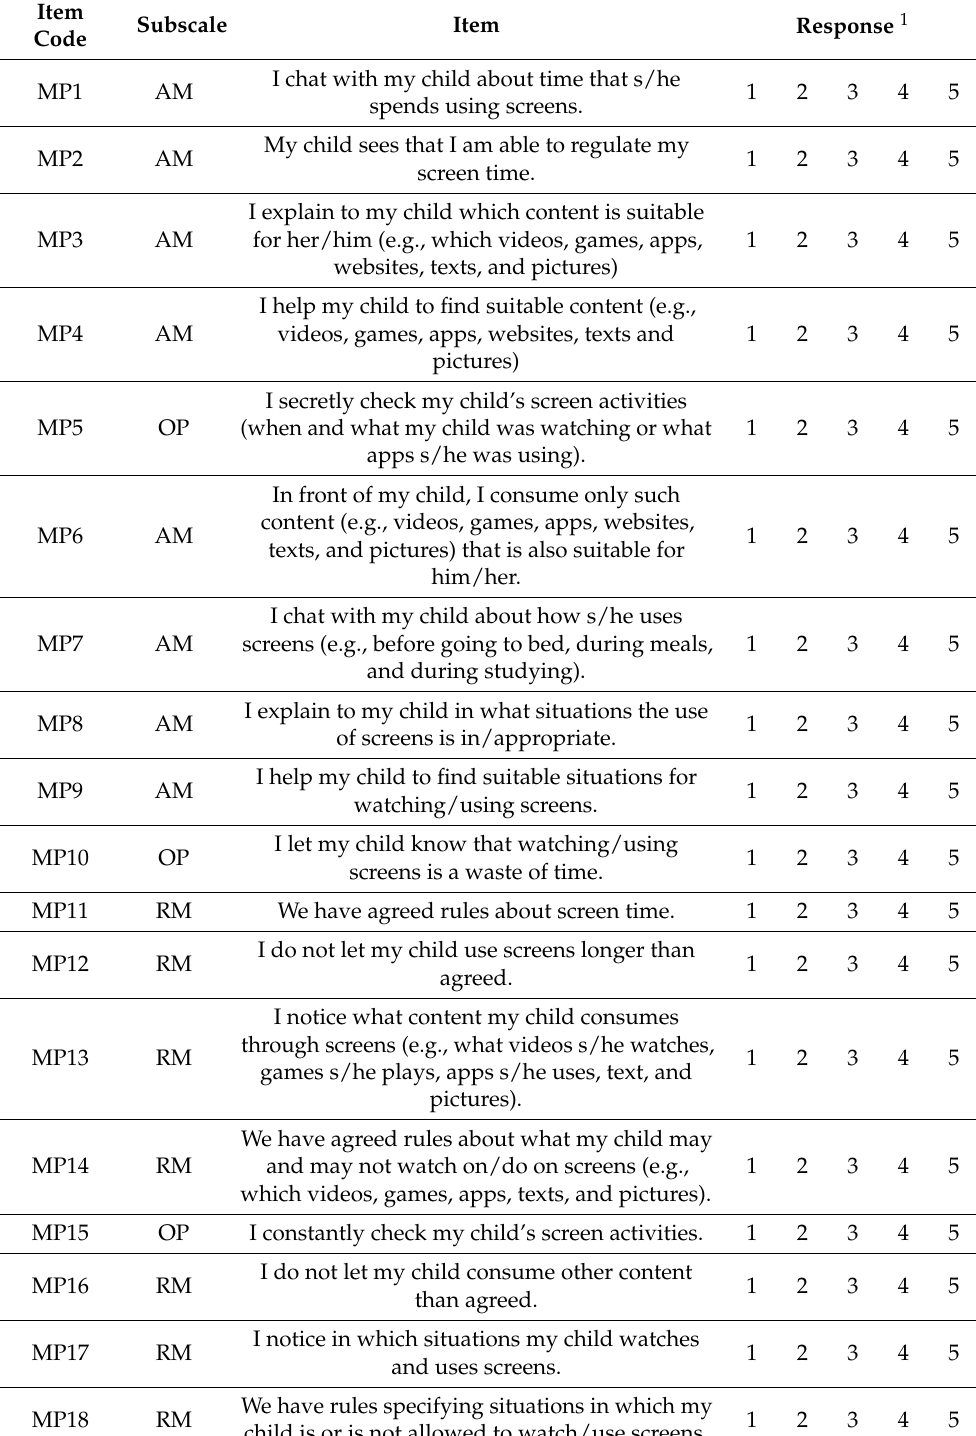
Table A4. MEPA-20: English